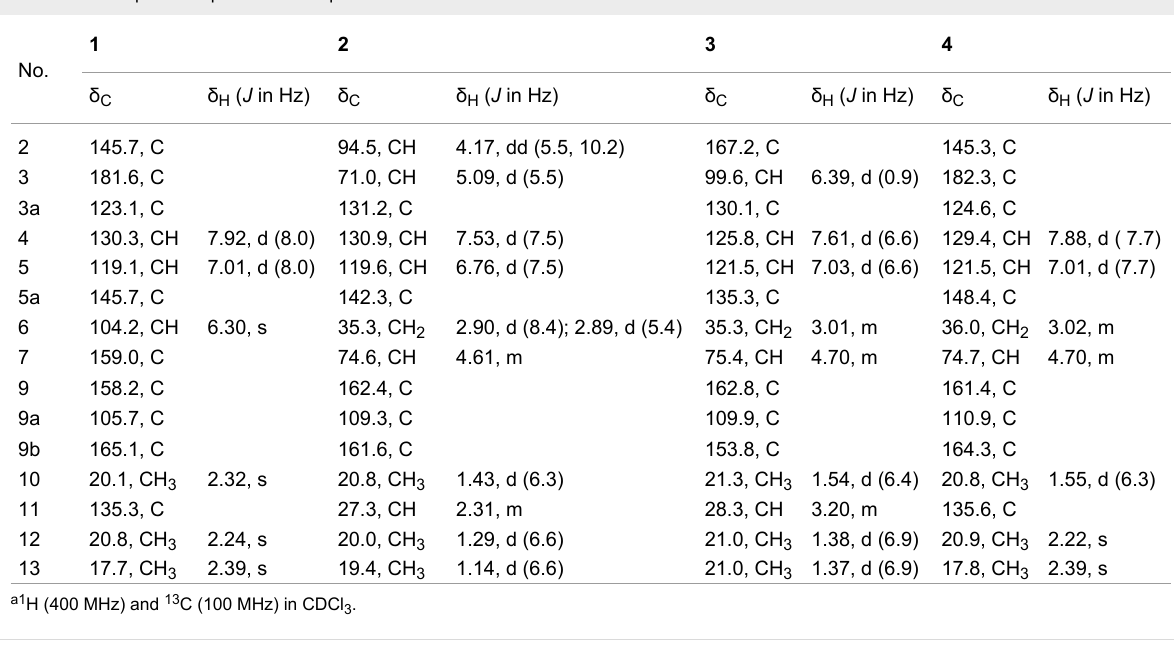
Table 1: NMR spectroscopic data of compounds 1 – 4 . a